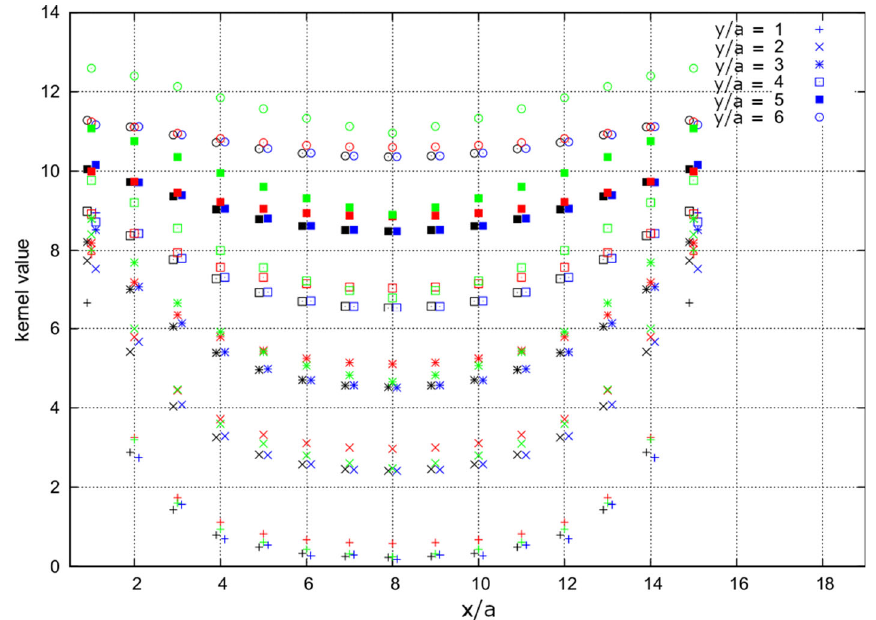
are shifted vertically by two units. The blue and black data points show the Fourier transform; the blue correspond to the naive discretization of the position space kernel, whereas the black to the sin regularized kernel. Surprisingly, both data sets agree quite well. The red data points show the corresponding momentum kernel with the usual ¯ k / ˆ k 2 defi- nition, whereas the green data points are calculated using the simple lattice